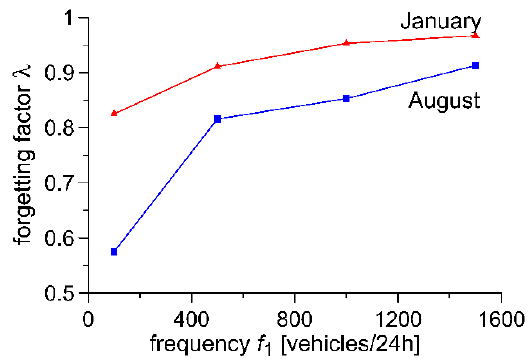
Figure 10. Comparison of precision of WIM systems optimised for various temperature fluctuation ranges.